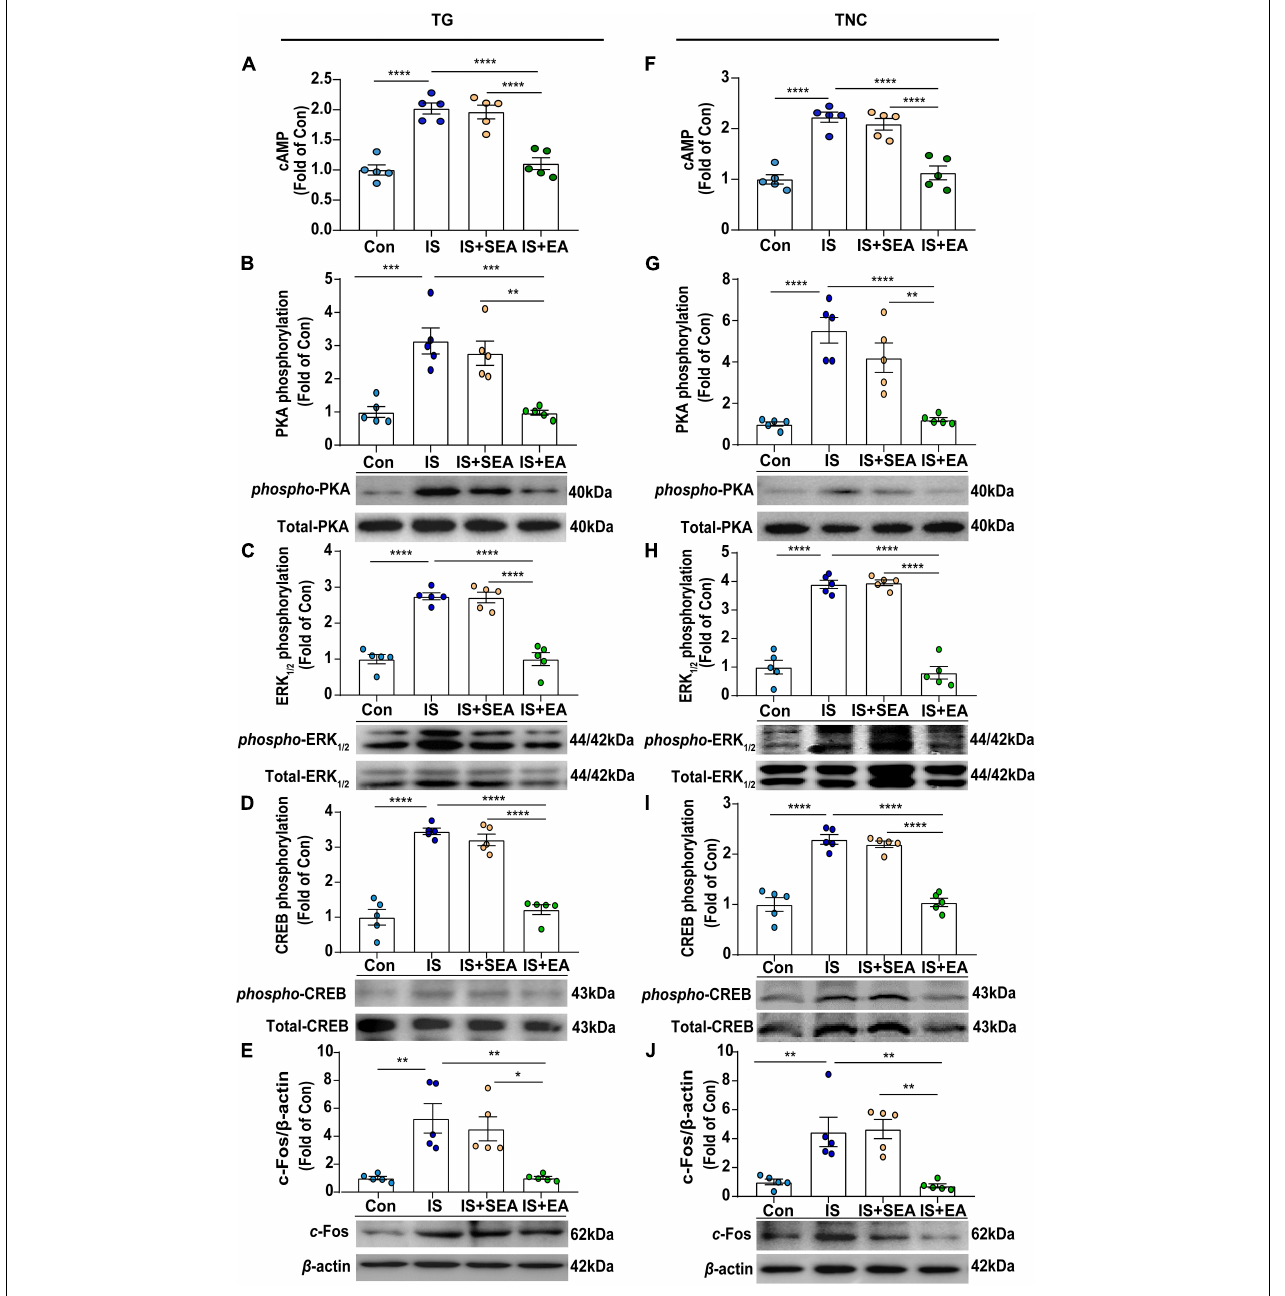
FIGURE 6 | Effects of EA on the protein levels of cAMP and 5-HT 7 R-associated PKA, ERK 1 / 2 phosphorylation signaling pathway in dural 4th IS-injected rats. Results were averages of cAMP production as evaluated by ELISA ( n = 5) (A,F) . Representative Western blots of phosphorylated and total PKA (B,G) , extracellular signal-regulated protein kinase 1 / 2 (ERK 1 / 2 ) (C,H) , CREB (D,I) , as well as c-Fos (E,J) . The densitometric analysis of phosphorylated and c-Fos protein levels detected from the TG and TNC of Con, IS, IS + SEA, IS + EA. One-way ANOVA followed by post hoc Tukey test. Group values are indicated by mean ± SEM. * P < 0.05, ** P < 0.01, *** P < 0.001, **** P < 0.0001. 5-HT 7 R, 5-hydroxytryptamine (5-HT) 7 receptor; cAMP, cyclic adenosine monophosphate; PKA, protein kinase A; ERK 1 / 2 , extracellular signal-regulated kinase 1 / 2 ; CREB, cAMP-responsive element-binding protein. TNC, trigeminal nucleus caudalis; TG, trigeminal ganglion; EA, electroacupuncture; IS, inflammatory soup; SEA, sham electroacupuncture; Con, control.